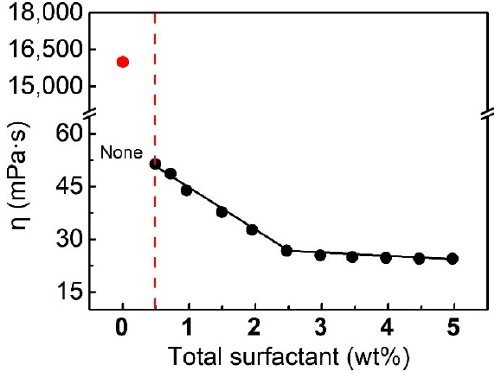
Figure 5. The influence of surfactant concentration on heavy oil emulsion viscosity at 50 °C. The molar ratio of OA and cyclen was set as 4:1, and the mass ratio of oil and OA/cyclen aqueous solu- tion was set as